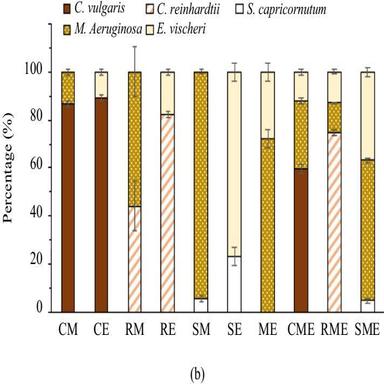
Composition of the PBR cultures (a) and population distribution of the mixed cultures (b) as indicated by flow cytometry: the columns indicate the average values of the results for different cultures after Day 20 (n = 15), with error bars displaying the corresponding standard deviations.